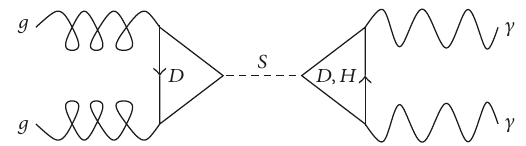
Figure 1: Production and diphoton decay of the Standard Model singlet scalar